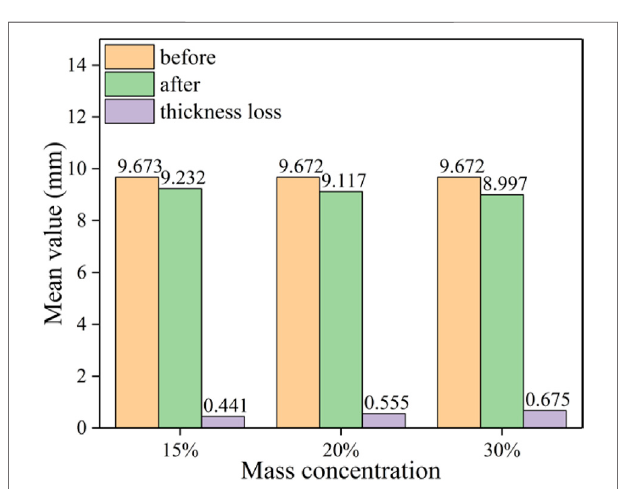
FIGURE 5 | Mean thickness of the blade at the measuring point related with different mass concentrations.